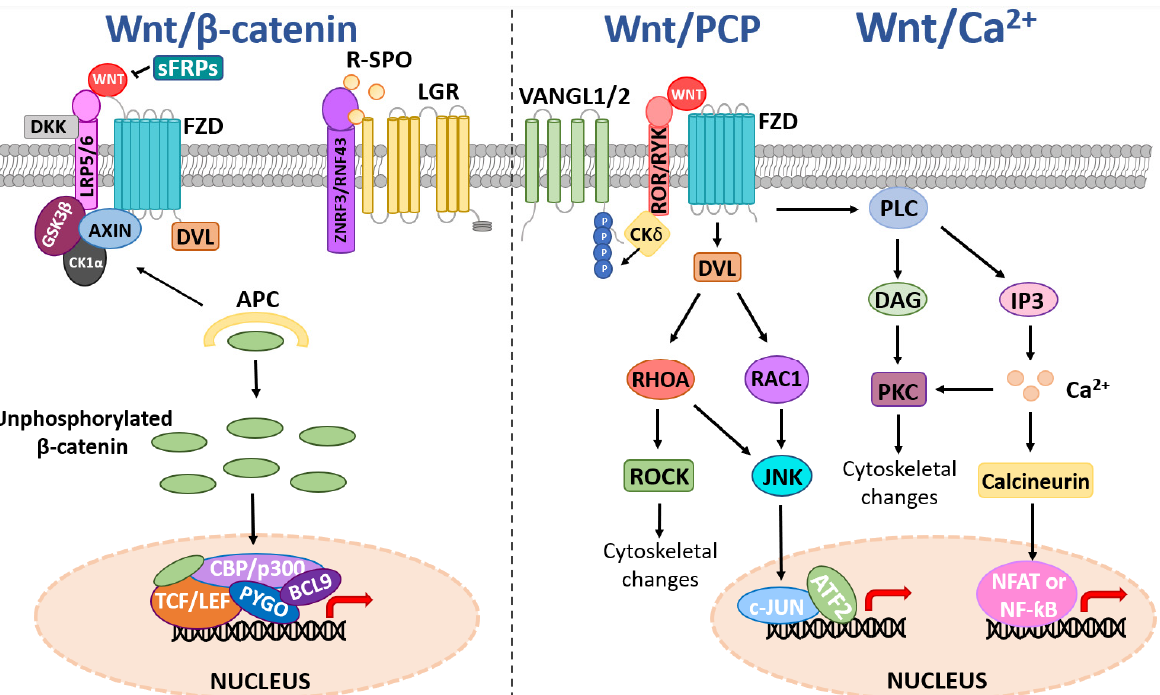
Figure 1. Schematic of canonical and non-canonical Wnt signaling. Canonical Wnt signaling is activated upon Wnt ligand binding to FZD Wnt receptors and Wnt co-receptors such as LRP5/6, causing the recruitment of DVL to the plasma membrane. This causes the destruction complex (AXIN1/2, APC, GSK3 β , CK1 α ) to dissociate, allowing the stabilization and accumulation of unphosphorylated β -catenin in the cytoplasm. β -catenin can then translocate to the nucleus where it associates with TCF/LEF, CBP/p300, PYGO1/2, and BCL9 to regulate the expression of Wnt target genes. Negative regulation of the canonical Wnt pathway can occur via multiple mechanisms, including extracellular sFRPs preventing FZD-Wnt binding and DKK-mediated inhibition of LRP5/6. Wnt ligand activation of the non-canonical Wnt/PCP pathway involves signal transduction via a complex of FZD Wnt receptors and Wnt co-receptors (e.g., ROR, RYK, and VANGL1/2), leading to plasma membrane recruitment and activation of DVL and CK1 δ / ε -mediated phosphorylation of VANGL2. DVL binds to the small GTPase; Rac1, RhoA to activate ROCK and JNK. This can lead to ROCK-mediated cytoskeletal rearrangements or JNK regulation of target genes via phosphorylation of transcription factors such as c-JUN, which can associate with proteins such as activation of transcriptional factor 2 (ATF2). The Wnt/Ca 2+ pathway activation leads to increased PLC activity, stimulating the production of DAG that activates PKC, and IP3 that triggers intracellular release of Ca 2+ ions. This results in downstream signaling events such as cell cytoskeletal rearrangements and calcineurin-mediated transcriptional responses via transcription factors such as NFAT or NF- ƙ B.